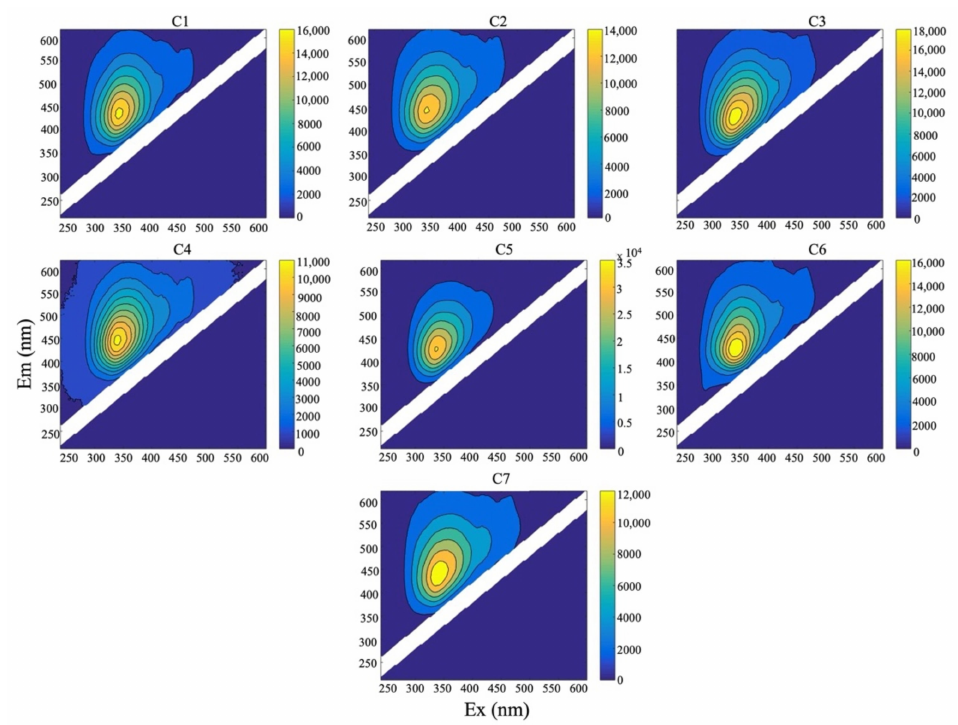
Figure 3. Composition of fulvic acids (FAs) for different treatments. Compost labels according to the target waste: ( C1 ) fish waste; ( C2 ) horse manure; ( C3 ) sewage sludge; ( C4 ) green waste; ( C5 ) kitchen biowaste; ( C6 ) H. illucens frass; and ( C7 ) vermicompost. The color scale is presented in relative units.